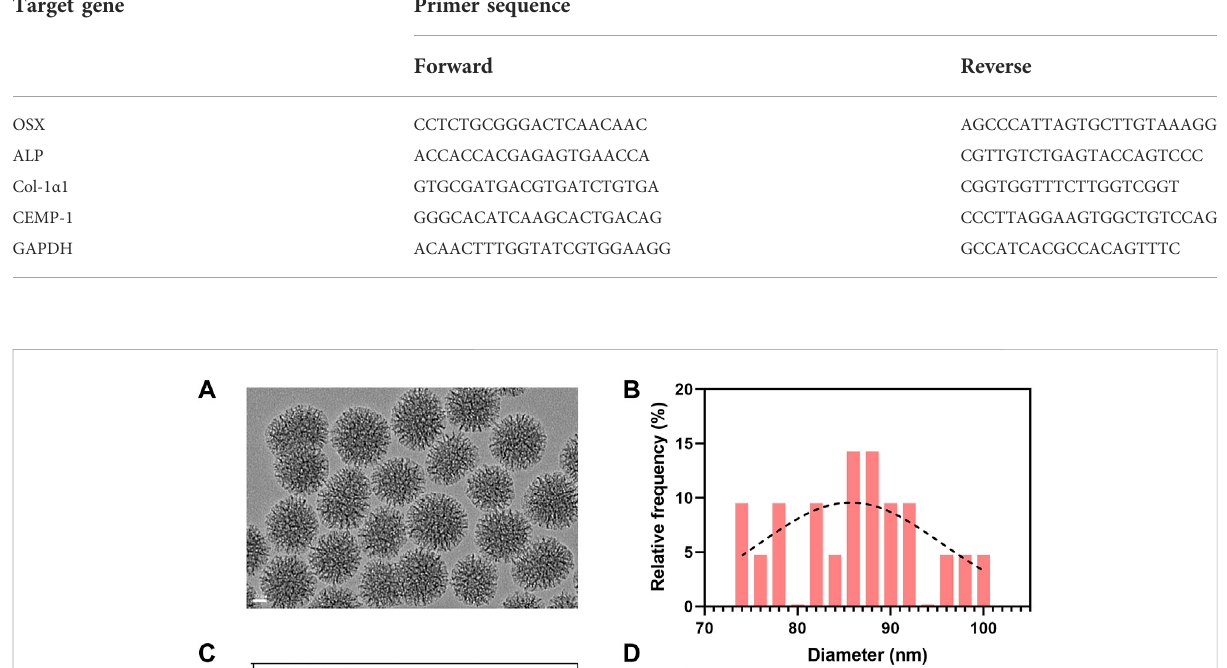
TABLE 2 Primers used for real-time quantitative RT-PCR.